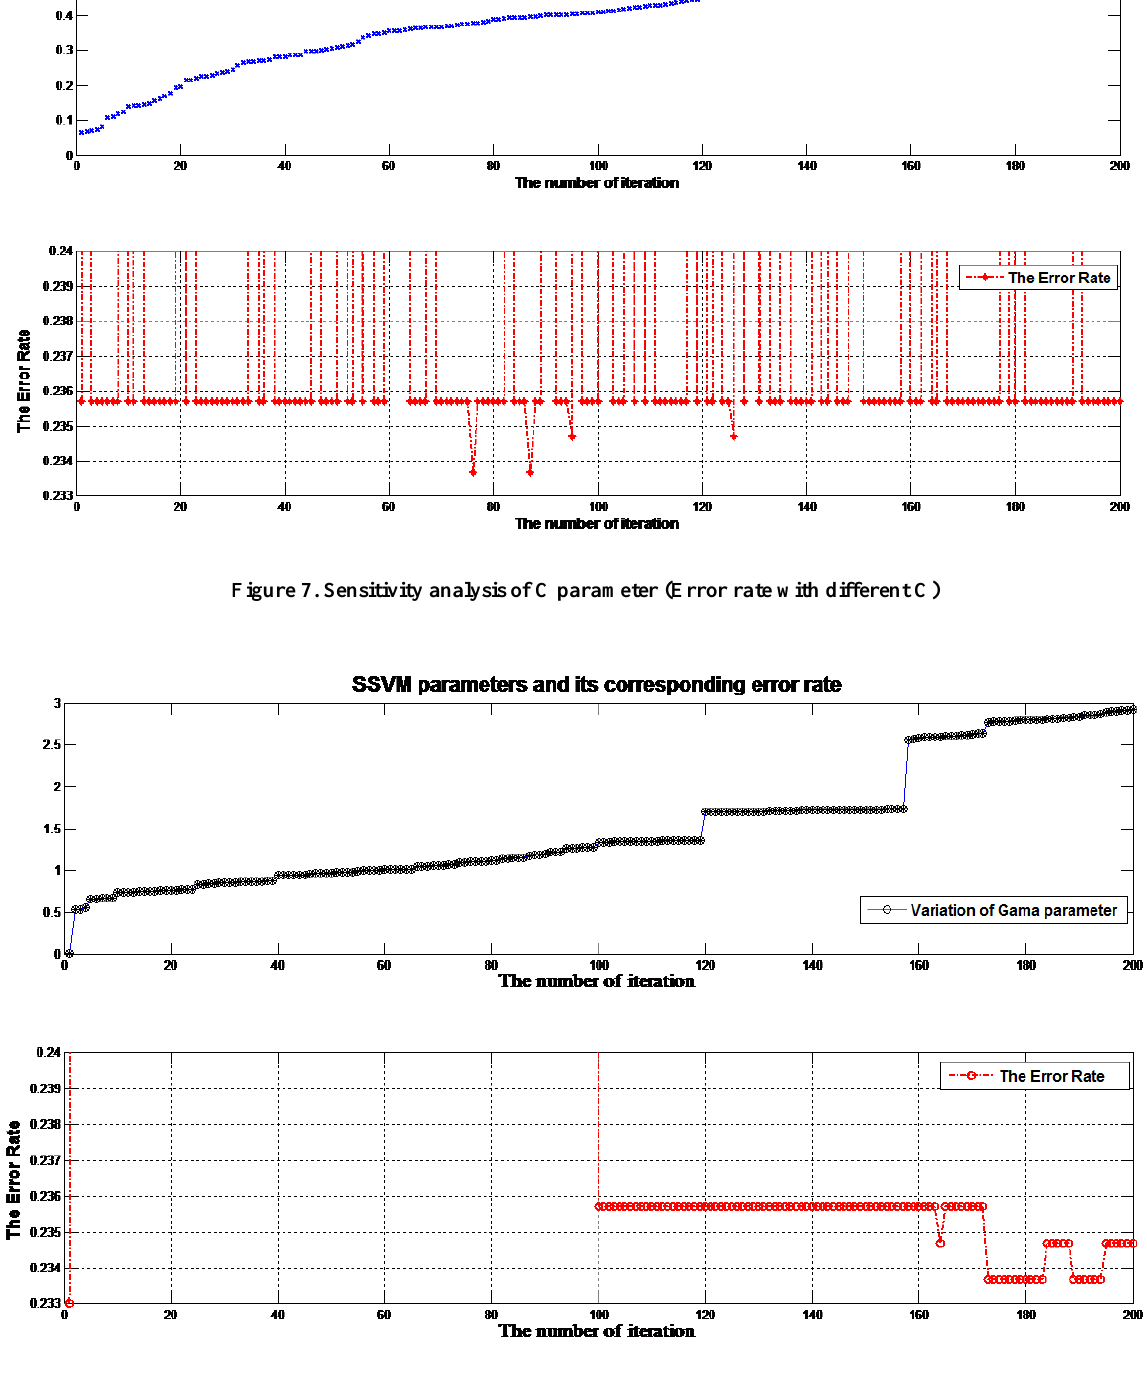
Figure 8. Sensitivity analysis of gama parameter (Error rate with different